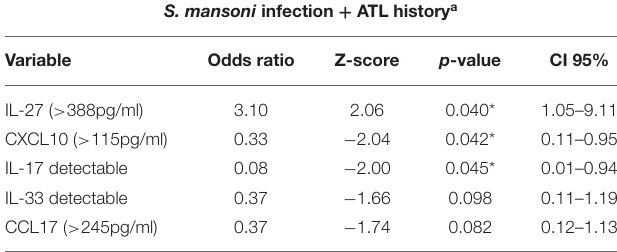
TABLE 7 | Multiple regression model showing an association between previous report of ATL with serum levels of immune mediators among S. mansoni -infected individuals living in the rural community of Brejo do Amparo, Januária, Minas Gerais, Brazil. S. mansoni infection + ATL history